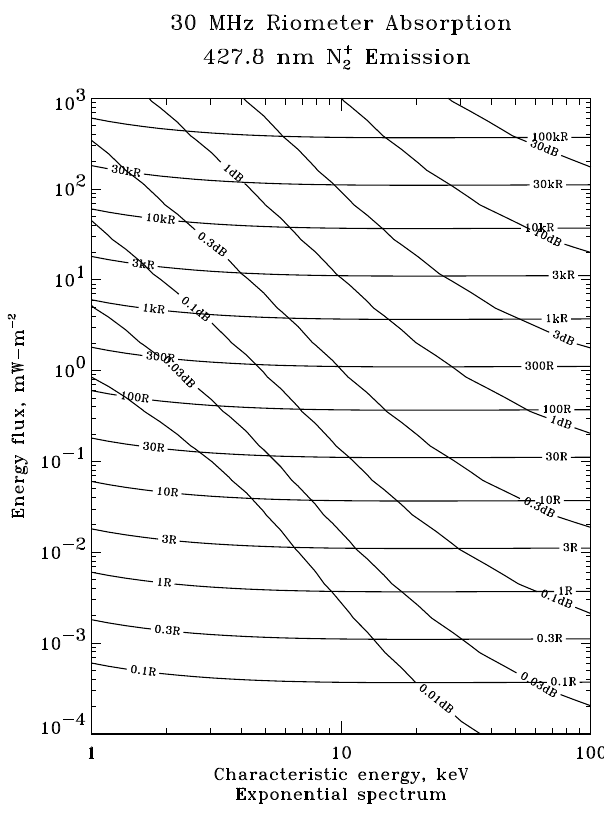
Fig. 11. Model calculations of 30 MHz broad-beam riometer ab- sorption and 427.8 nm N + emission intensity as functions of total 2 energy flux and characteristic energy for exponential electron spec-